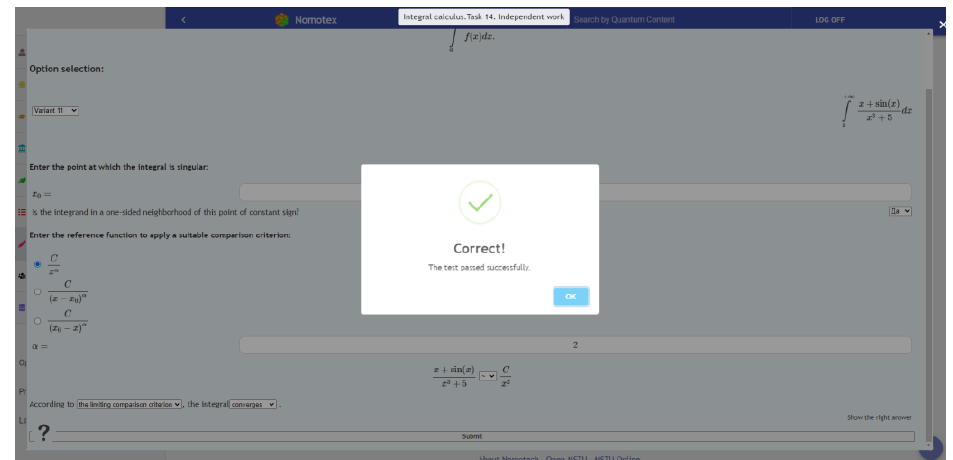
Fig. 6b. Entering the answer in the DLS “Nomotex”.